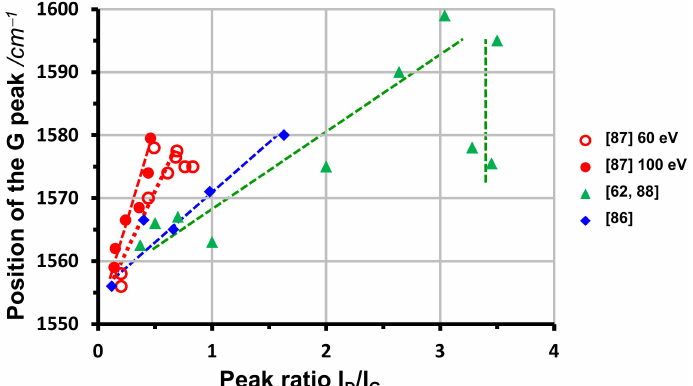
Figure 26. Variation of the G peak position for carbon films in dependence on the peak ratio I D /I G . Data from [62,88] (Laser-Arc deposition with ion energies of 80–90 eV), from [87] (filtered arc deposition with ion energies of 60 and 100 eV) and from [86] (filtered arc deposition with ion energies of 80